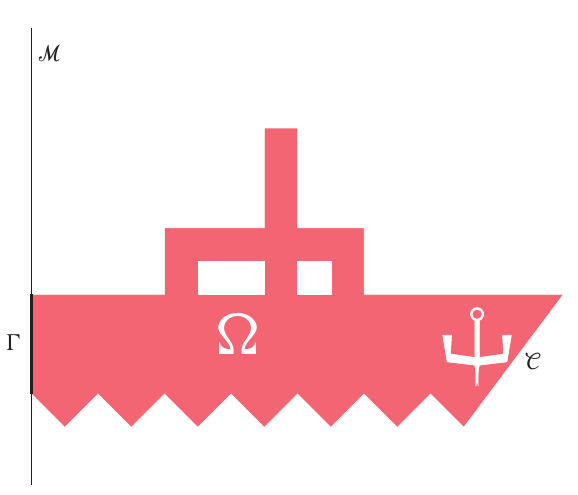
Figure 2. The ship sunk by Theorem